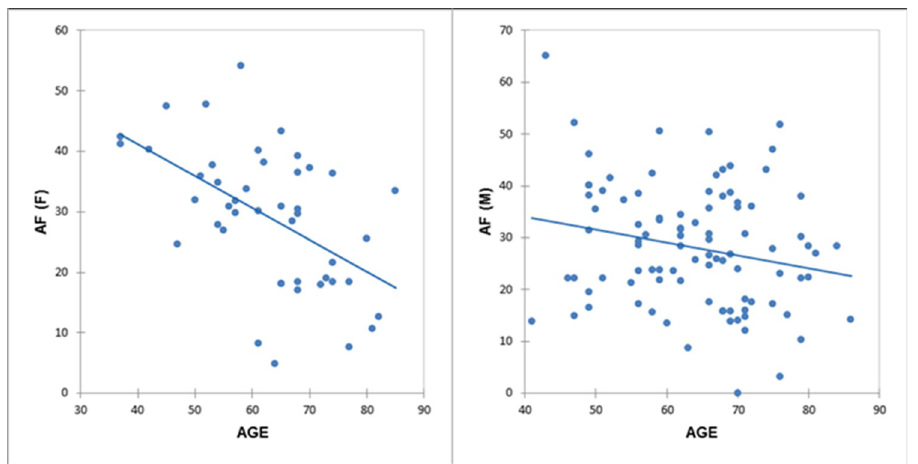
Fig 3. Correlations between age and alternate fluency with the sample stratified for gender. AF/females: r = − 0.53, p = 0.0002; AF/males: r = − 0.2, p = 0.38. AF , Alternate Fluency; F , Females; M , Males.